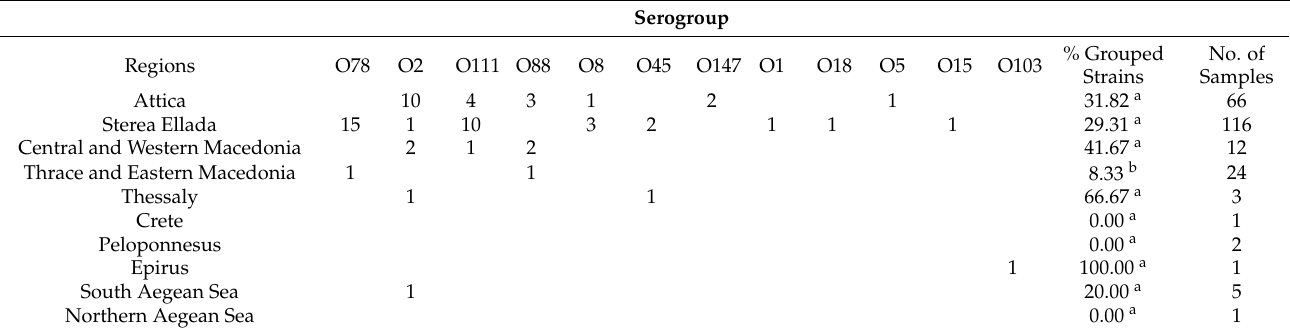
Table 2. Geographical distribution of serogrouped E. coli strains.